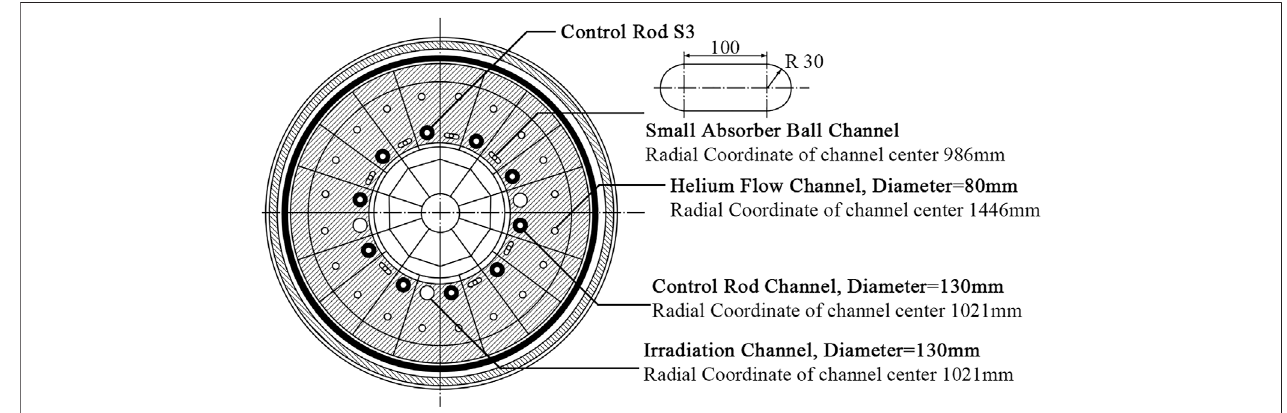
FIGURE 2 | HTR-10 reactor horizontal cross-section (IAEA, 2003).